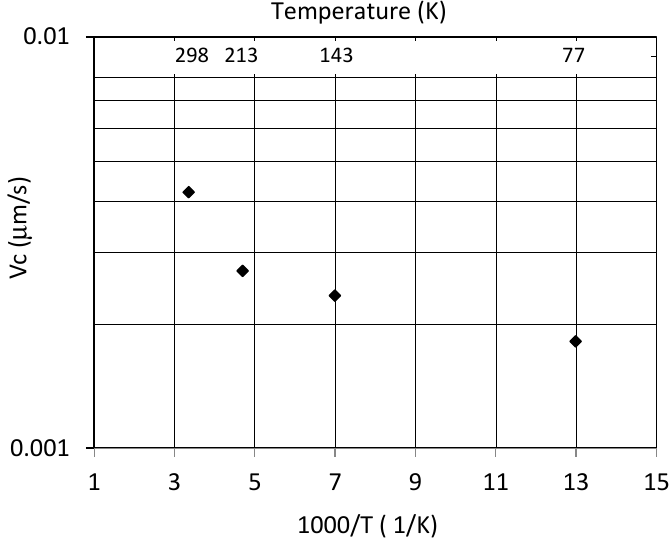
Figure 8. Estimated boundary migration rate at steady state (assuming that constant grain coarsening is responsible for the steady state grain size) as a function of temperature.